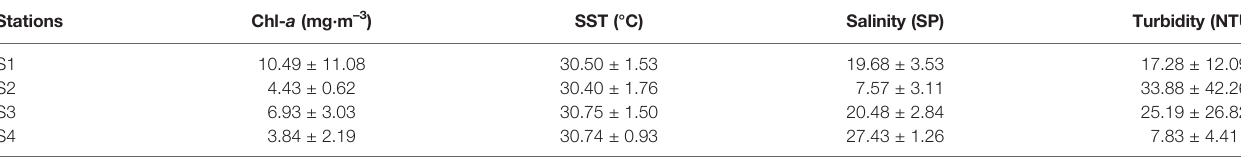
Data presented as mean ± standard deviation; N =